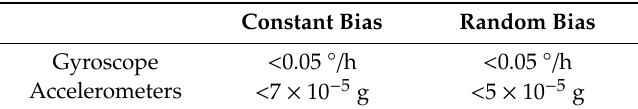
Table 4. Main parameters of the IMUs.